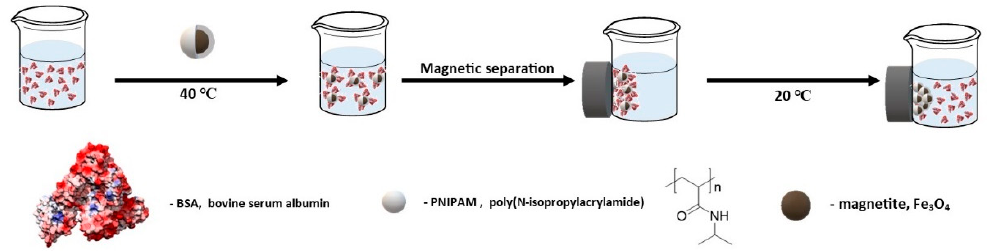
Figure 14. Adsorption and desorption scheme of protein on thermosensitive-polymer-coated magnetic particles.